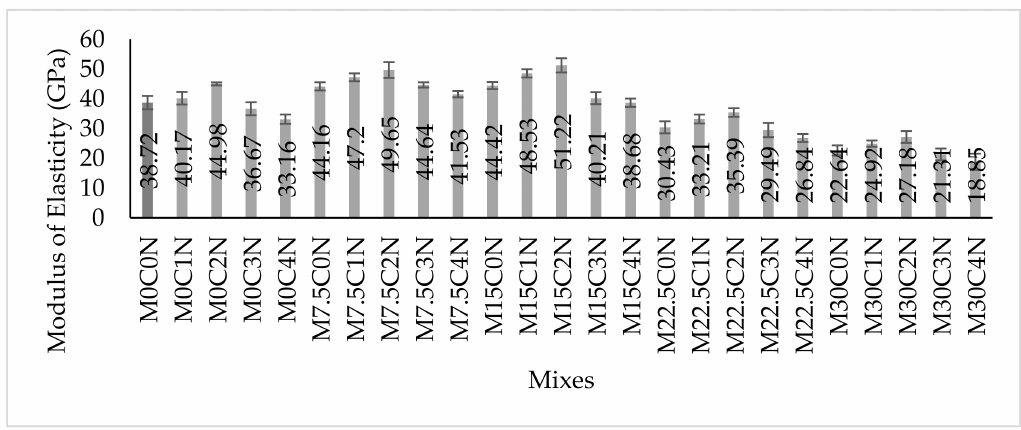
Figure 12. Modulus of Elasticity